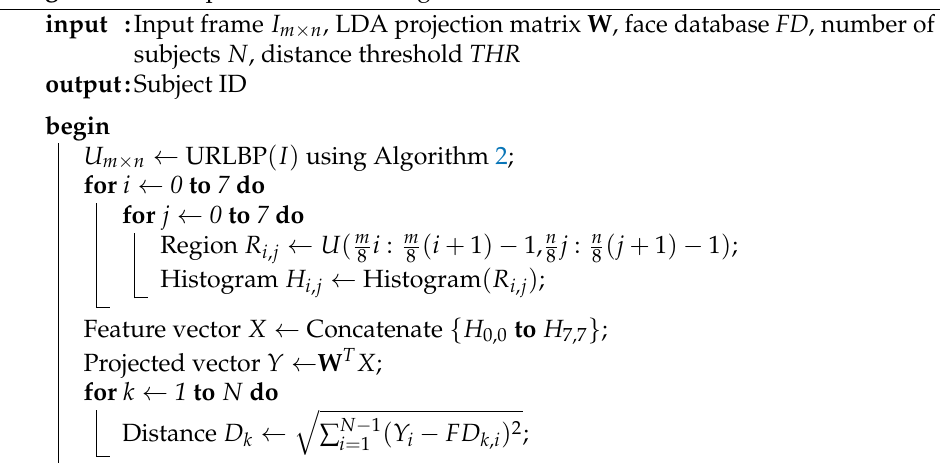
Algorithm 1: Proposed method using RLBP + LDA.